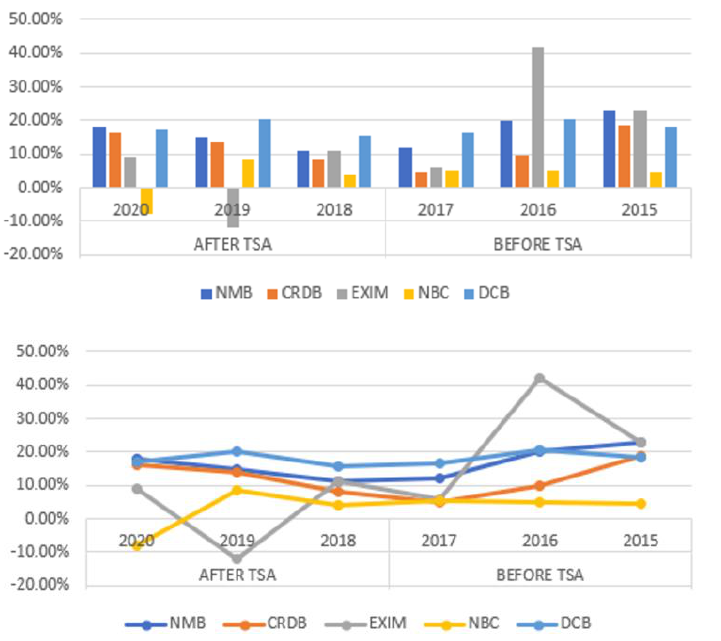
Figure 4: Earning Ability of the Commercial Banks (ROE); Source: Author’s Compilation, 2021